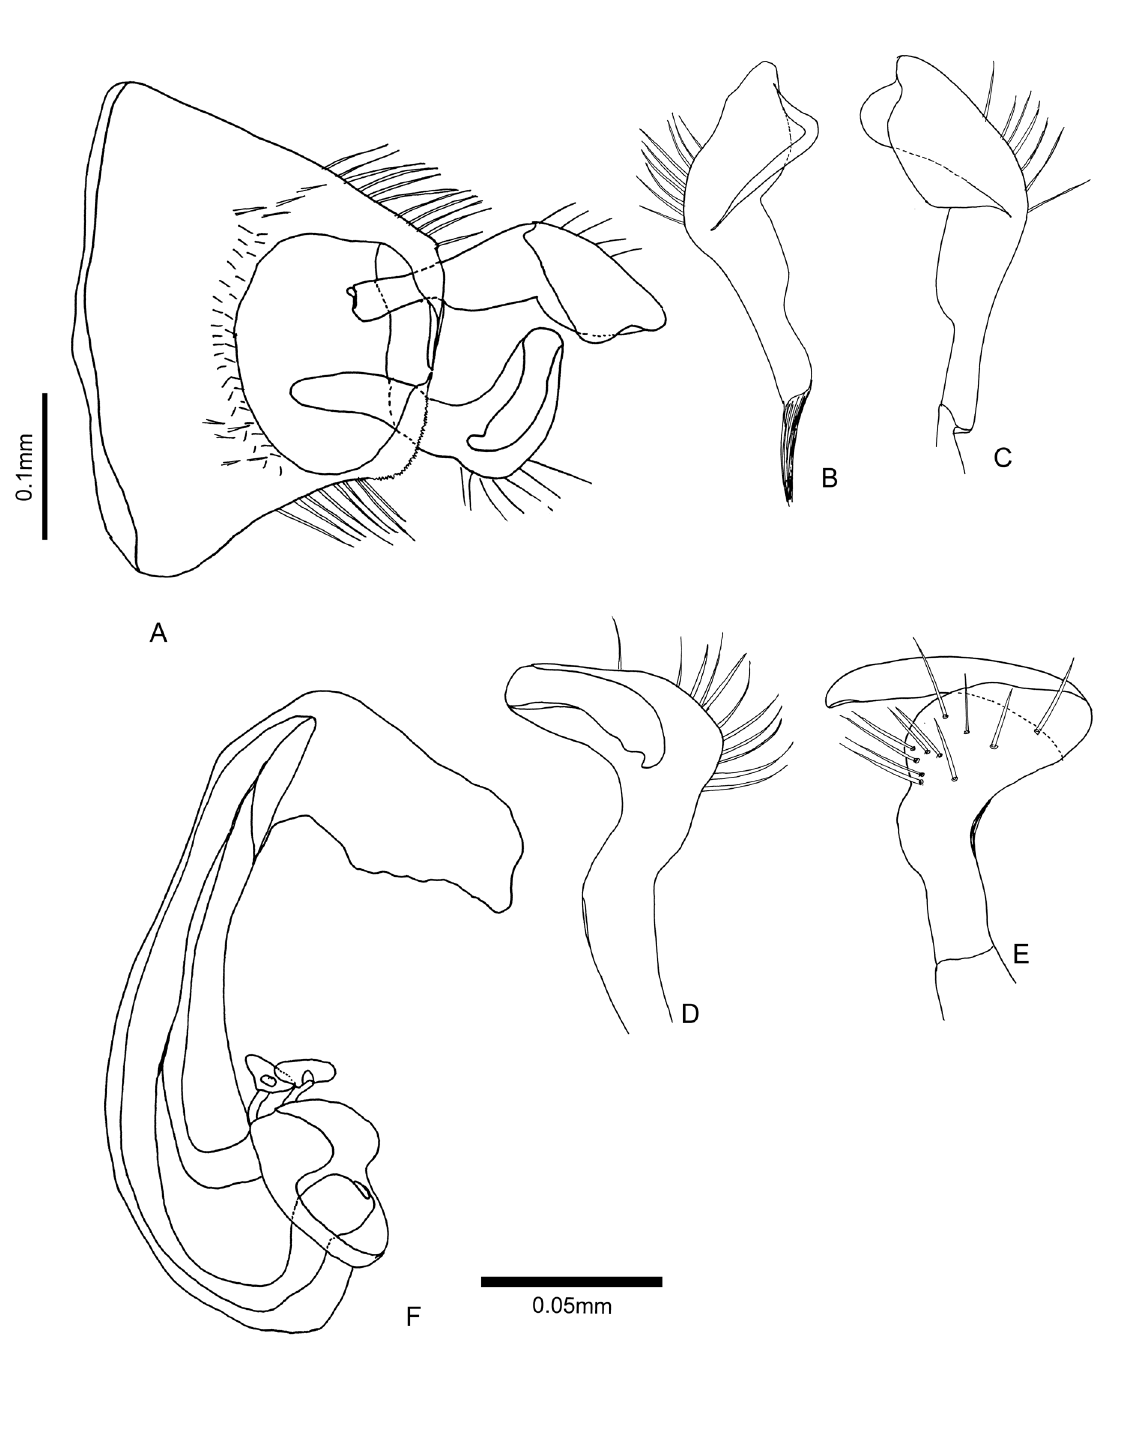
Fig. 12. Male genitalia of Ernestinus mimicus Distant, 1911, UASB. A . Genital capsule in dorsal view. B–C . Right paramere in dorsal view and ventral views. D–E . Left paramere in dorsal and lateral views. F . Aedeagus in lateral